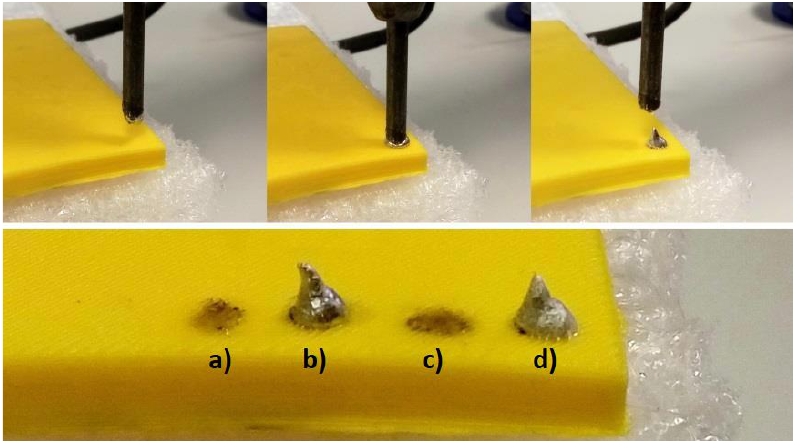
Figure 2. Results of adhesion tests of solder alloys on an ABS surface: ( a ) Sn60Pb40 with flux; ( b ) Sn60Pb40 without flux; ( c ) Sn99Ag0.3Cu0.7 with flux; ( d ) Sn99Ag0.3Cu0.7 without flux.